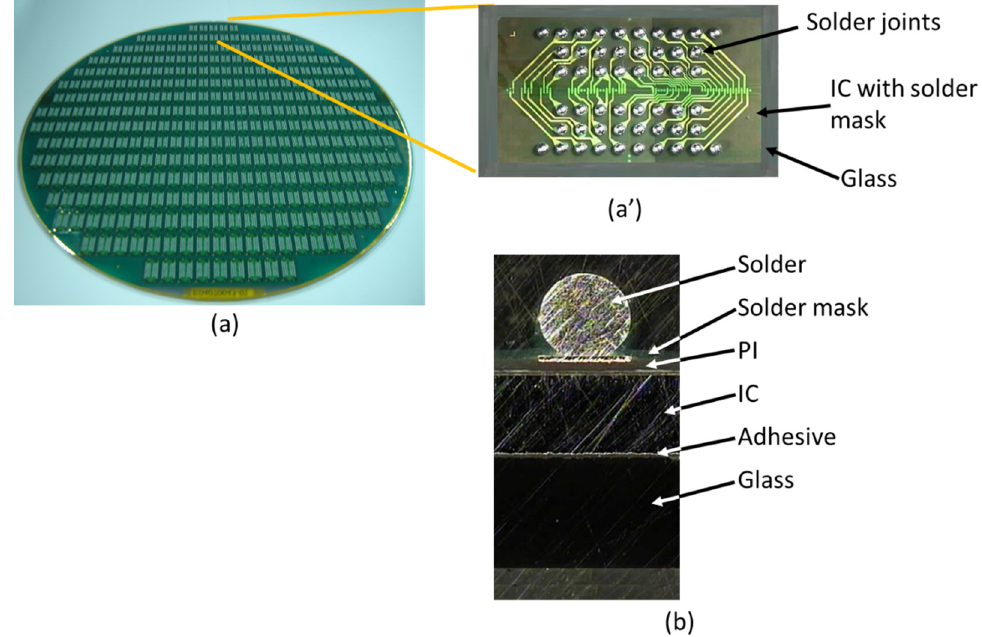
Figure 4. Glass distributed wafer level packaging: ( a ) wafer view with the detail ( a’ ) and ( b ) cross-section of a single device [15] (Copyright 2020 EuroSimE).